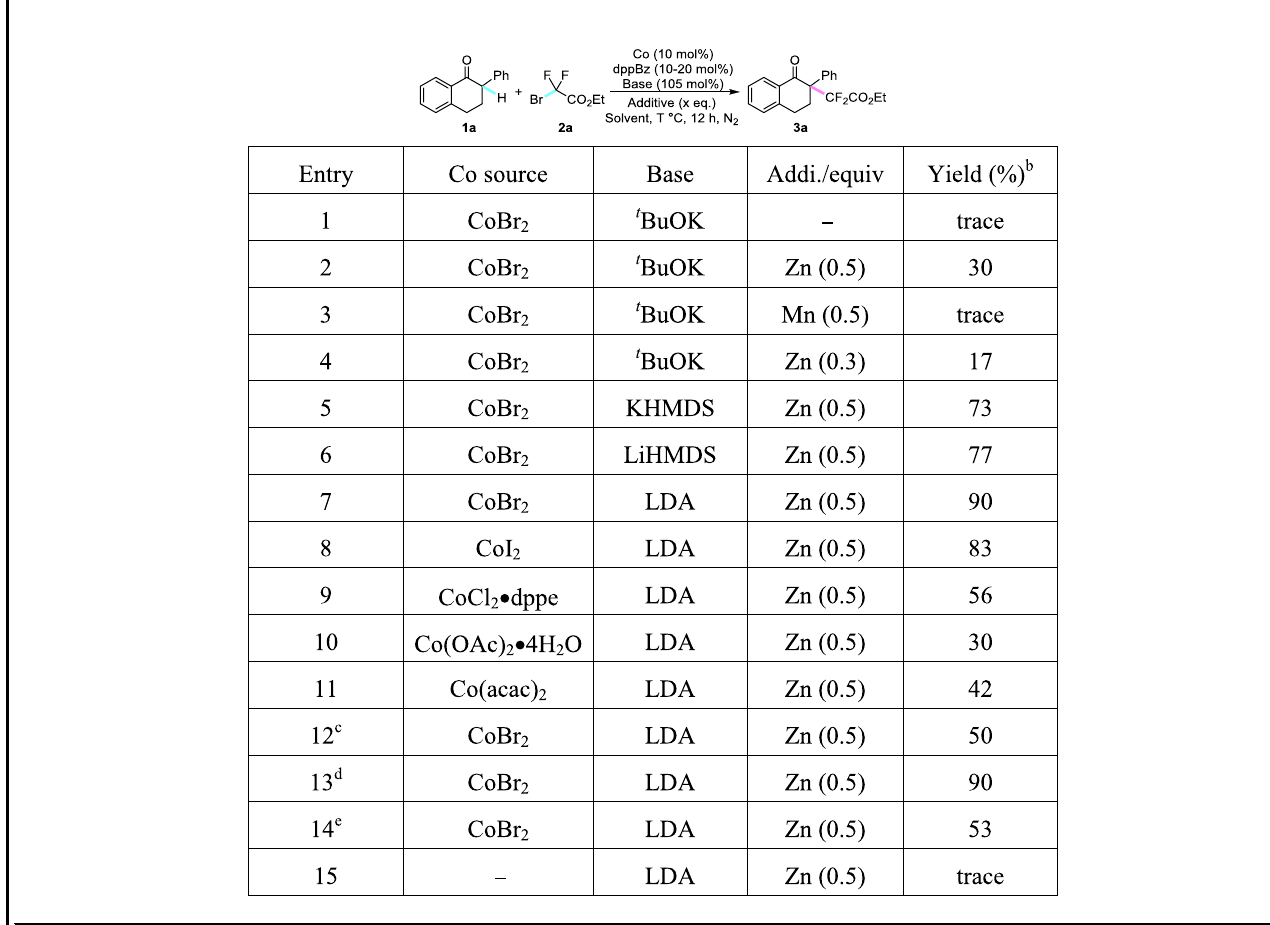
Table 1 Cobalt-catalyzed di fl uoroalkylation: optimization of conditions